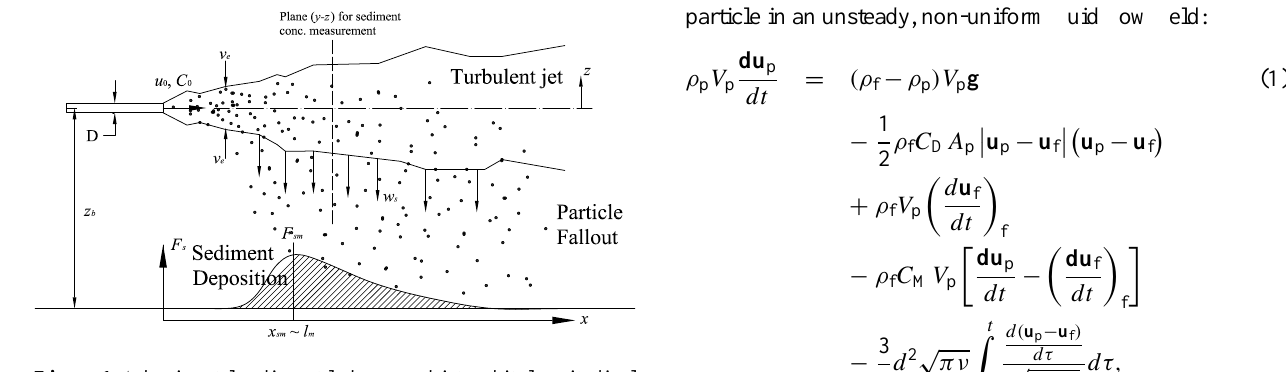
Figure 1. A horizontal sediment-laden round jet and its longitudinal Fig. 1. A horizontal sediment-laden round jet and its longitudinal bottom deposition (transversely lumped) bottom deposition (transversely lumped) profile.